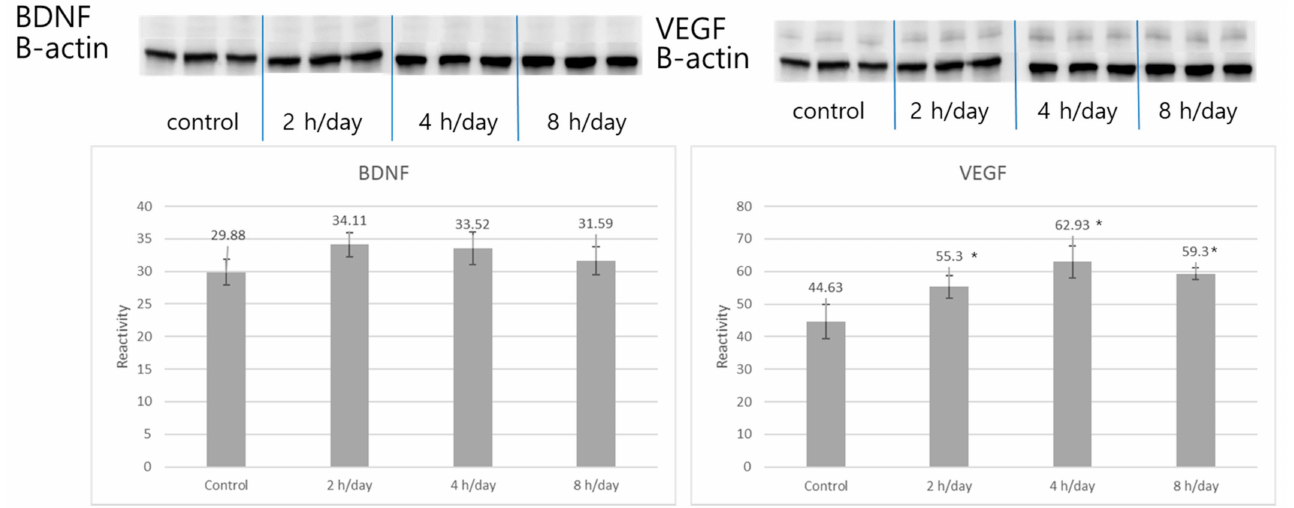
Figure 5. Western blot analysis of VEGF and BDNF expression. The VEGF protein was more reactive in the 2, 4, and 8 h per day groups compared with the control group ( p = 0.003). However, expression of the BDNF protein showed no difference among the groups ( p = 0.140). * p < 0.05 compared with control